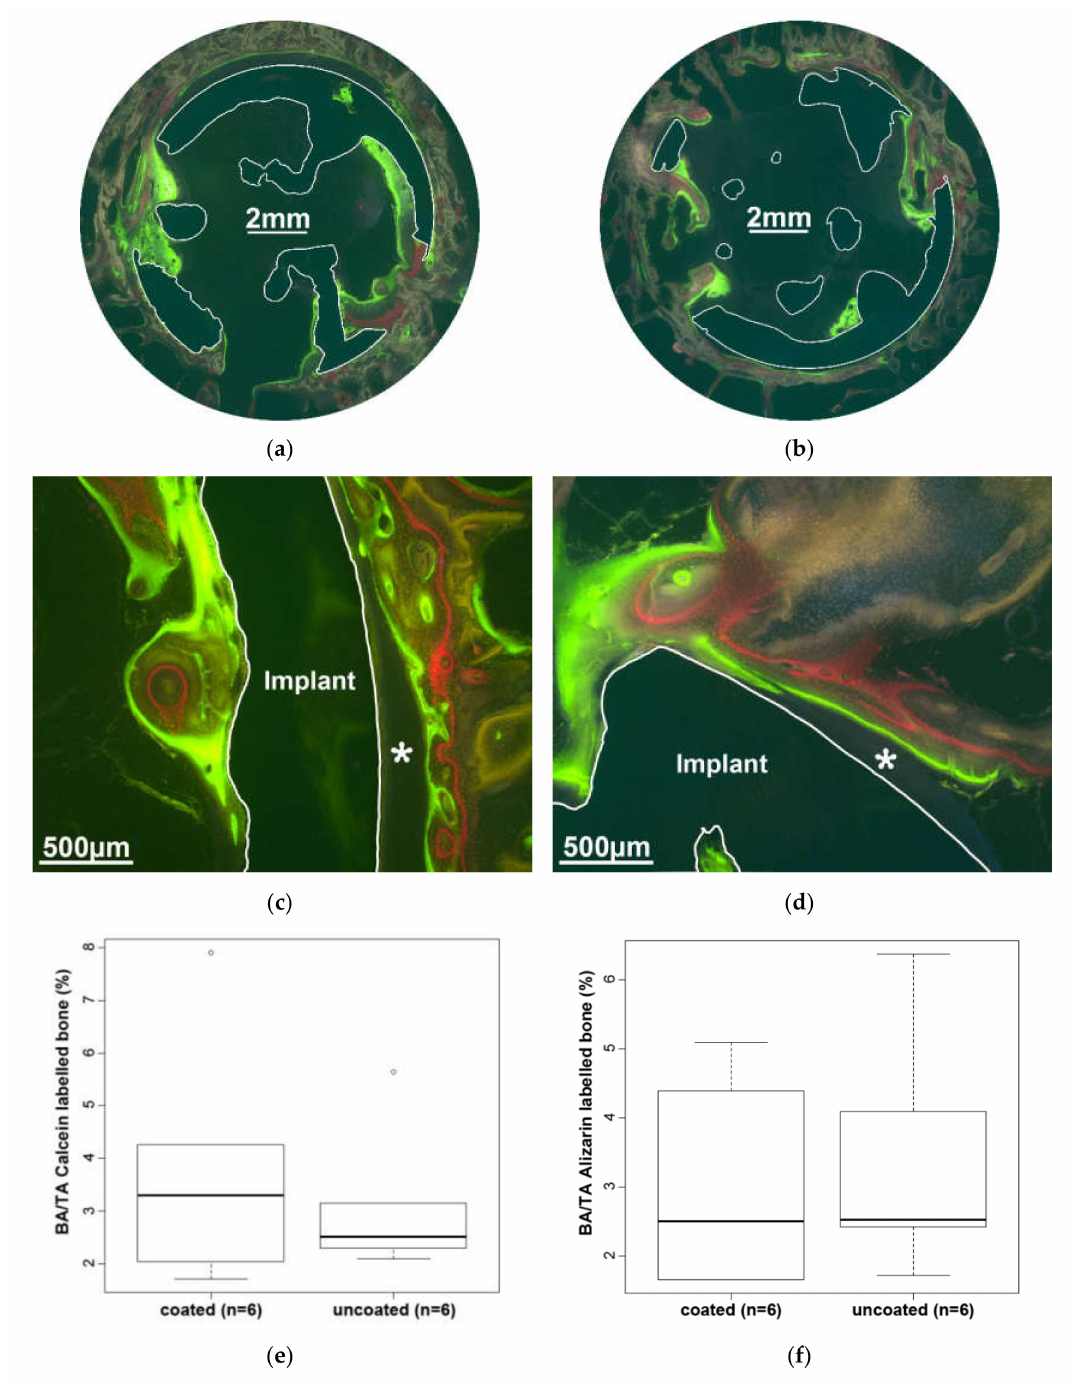
Figure 9. Overview and detail of a coated ( a , c ) and uncoated ( b , d ) implant (highlighted by a white border). The newly formed bone was labeled by three fluorochromes, Oxytetracycline (yellow), Alizarin Complexone (red), and Calcein (green), and shows the time point at which it was formed. An empty gap ( c , d *) is visible between the outer surface of the implant and the bone. In the area of interest (AOI), the bone area over tissue area (BA / TA) of both Calcein- ( e ) and Alizarin ( f )-labeled bone shows no significant di ff erences between coated and uncoated samples. Oxytetracycline-labeled bone was not subject of the